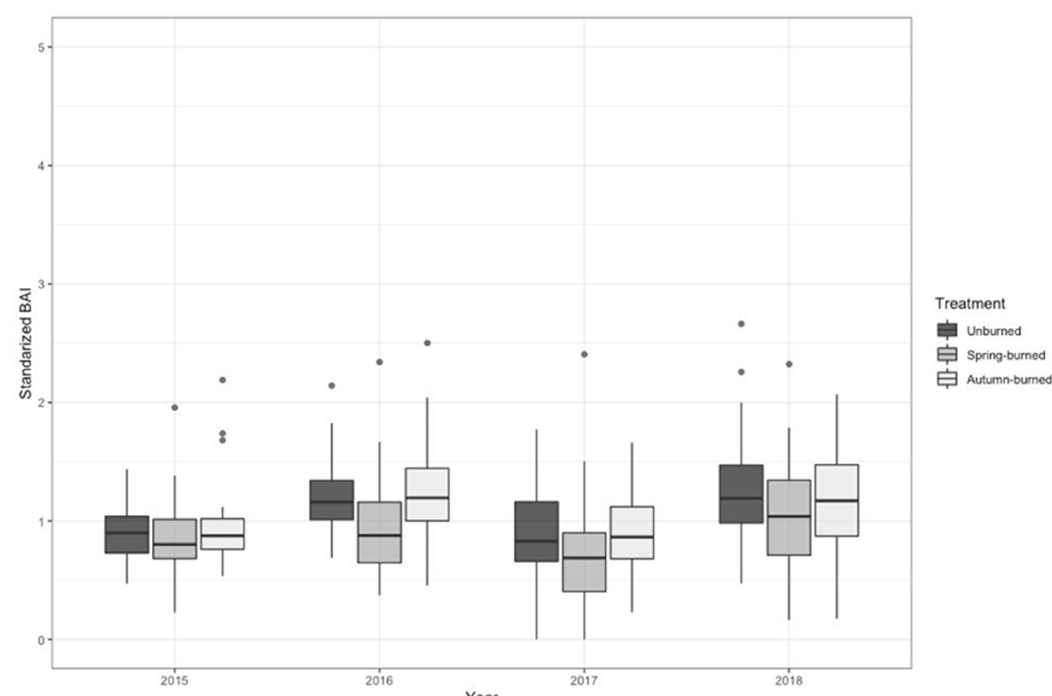
Figure 3. Box plot showing the differences in standardized BAI in the mixed stand. Spring burning was conducted in May 2016, autumn burning was carried out in November 2016.